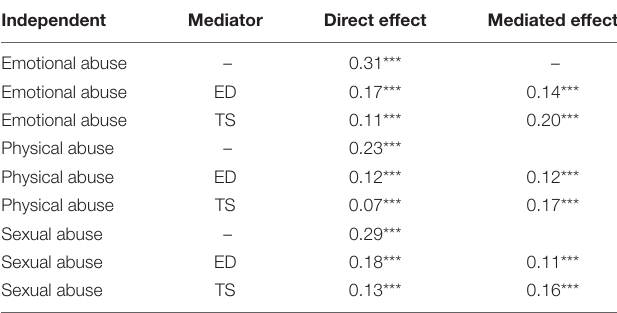
TABLE 3 | Effects with and without mediators (models